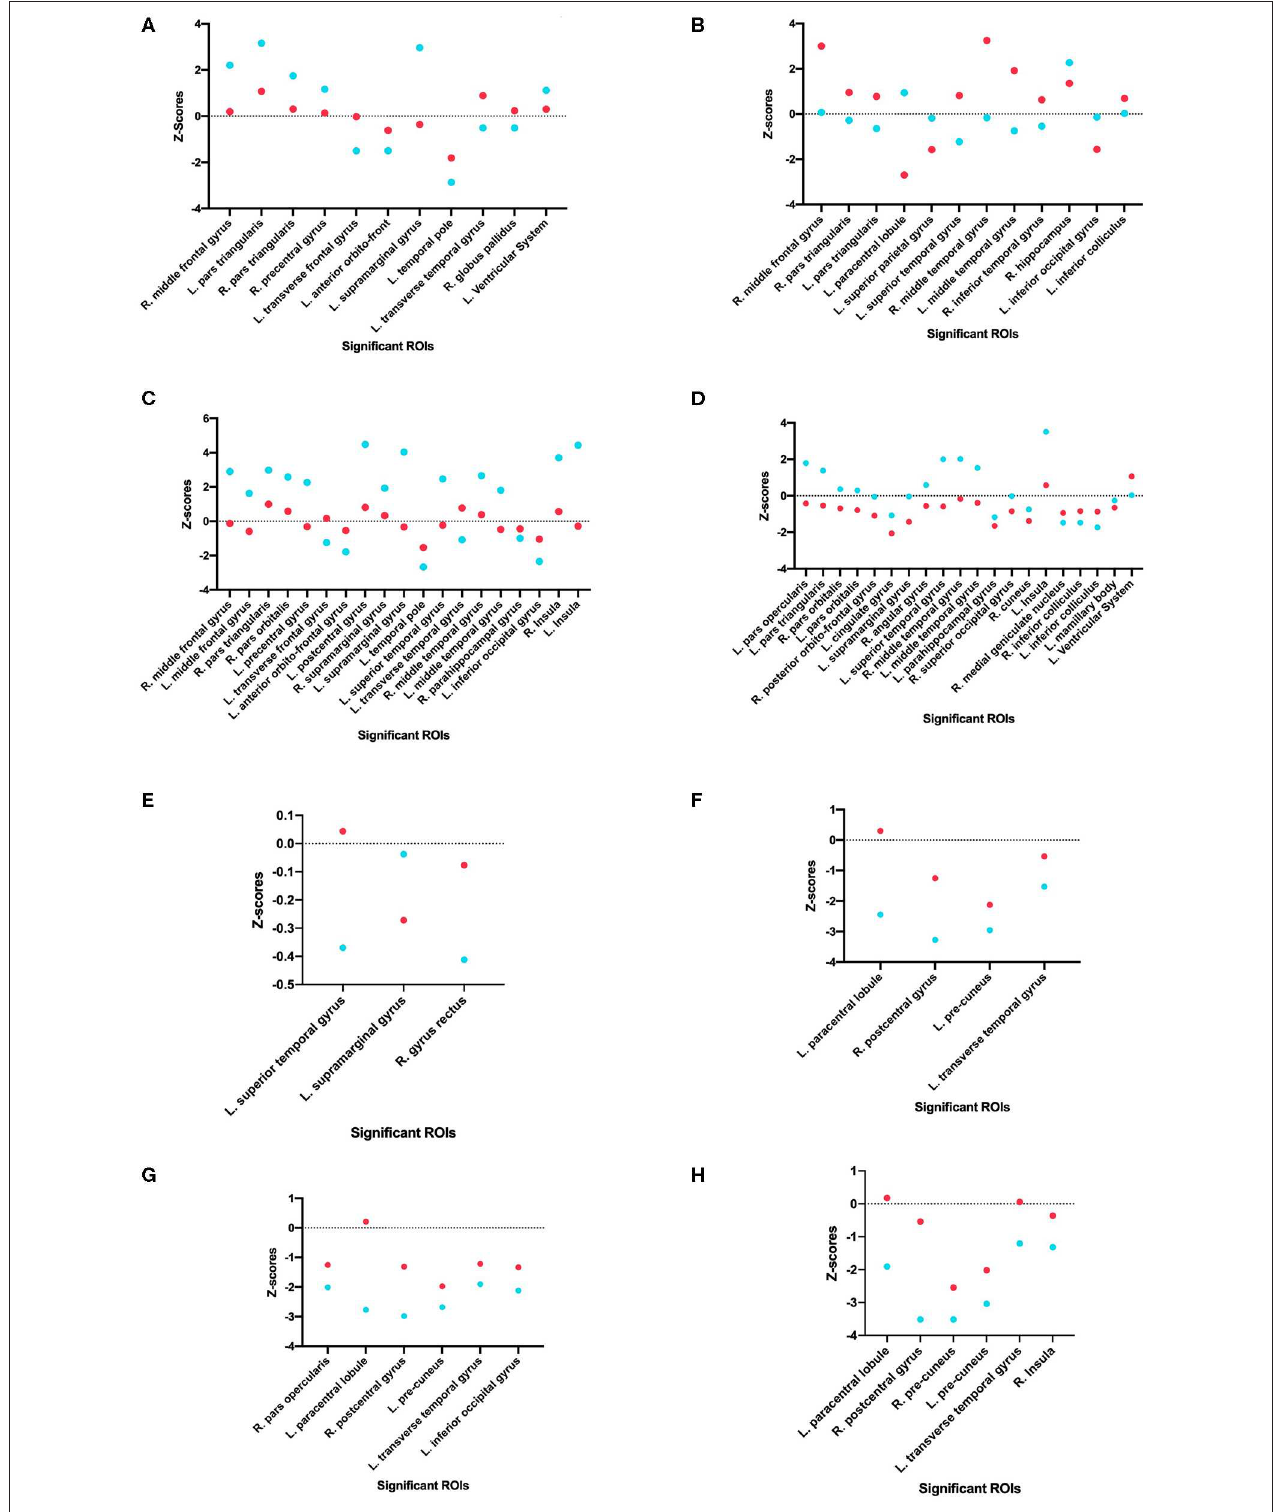
FIGURE 3 | Comparison of seizure and non-seizure subject groups, in terms of z-scores, for each significant ROI among the eight different categories of interest. The points with a more positive value indicate a raw score that is higher than the control, while points with a more negative value indicate a raw score that is lower than the control. Each graph indicates a different COI: (A) Gray matter volume, (B) White matter volume, (C) Total matter volume, (D) CSF volume, (E) Cortical thickness, (F) Mid cortical area, (G) Inner cortical area, and (H) Pial cortical area.